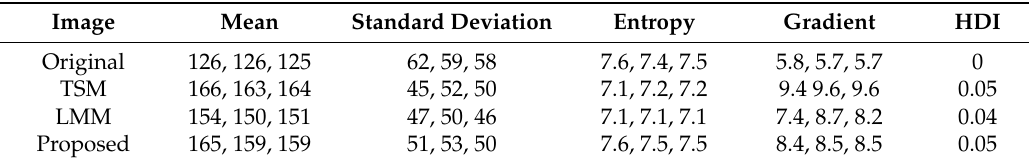
Table 6. Quantitative analysis of the methods in test